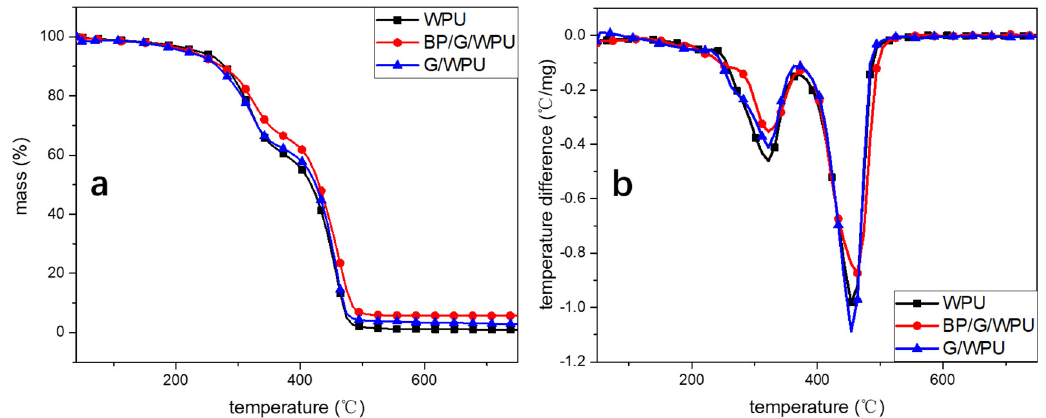
Figure 9. ( a ) the TGA curves; and ( b ) the resulted DTG curves.